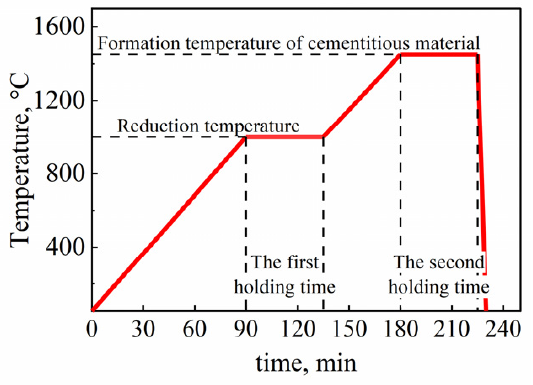
Figure 17. Schematic diagram of the two-stage heating